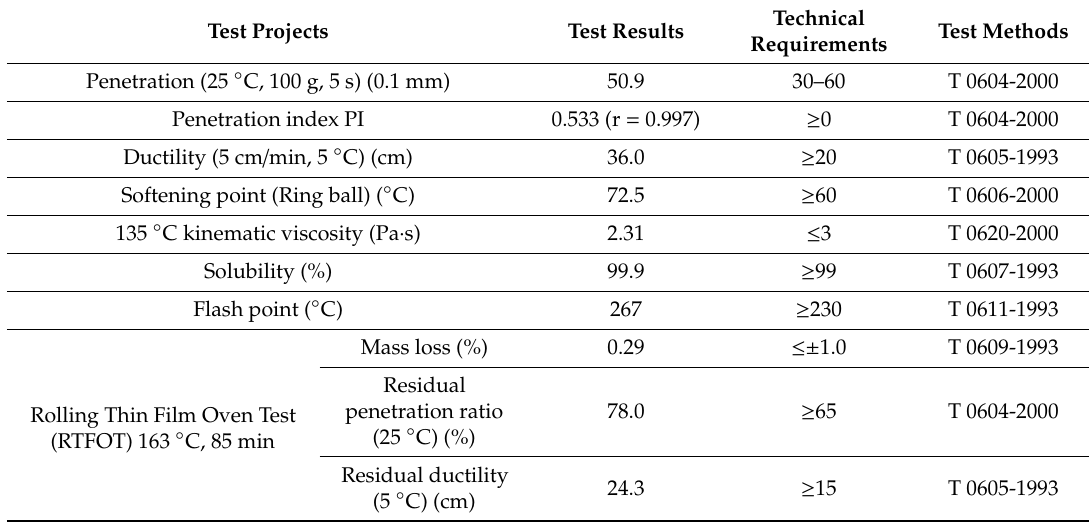
Table 1. Test results of Styrene-Butadiene-Styrene (SBS) modified asphalt.